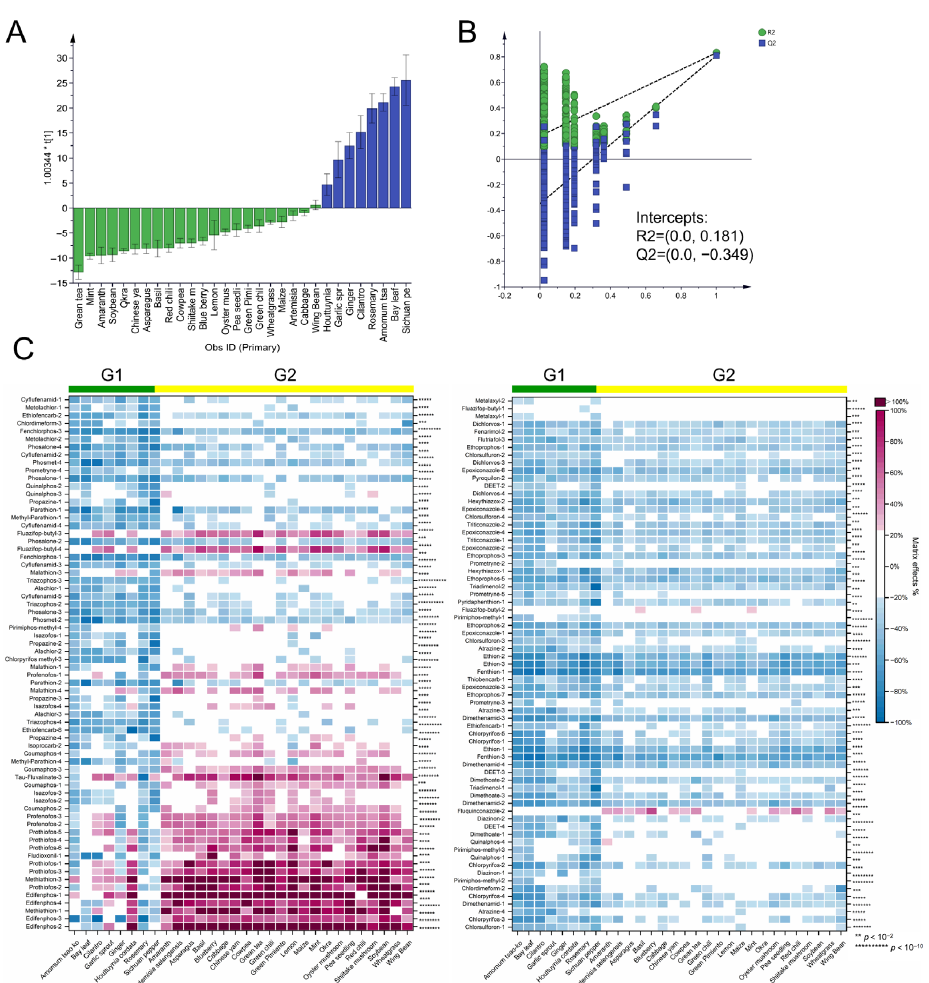
Figure 3. ( A ) The score plot of OPLS-DA modeling between groups G1 and G2; ( B ) the permutation test result (500 times); ( C ) the heatmap of MEs for 138 differential pesticide transitions between groups G1 and G2, 2 to 10 asterisks (** to **********) indicated significant difference ( p < 0.01 to p < 10 − 10